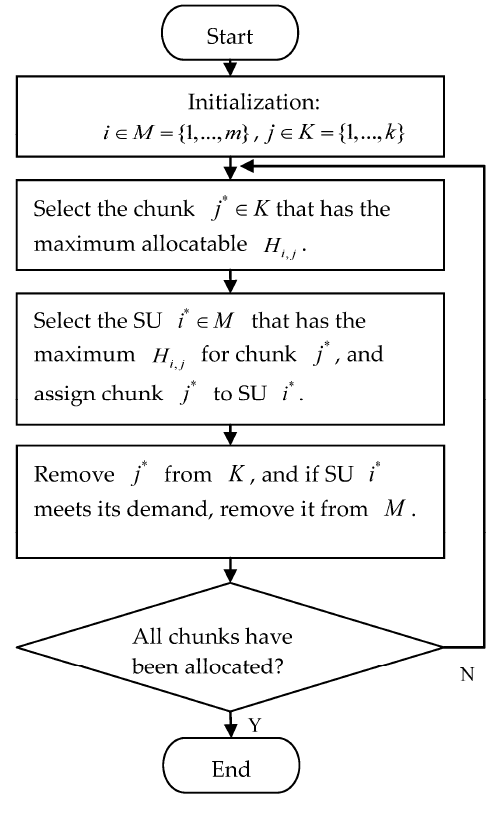
Figure 3. The procedure for chunk allocation.